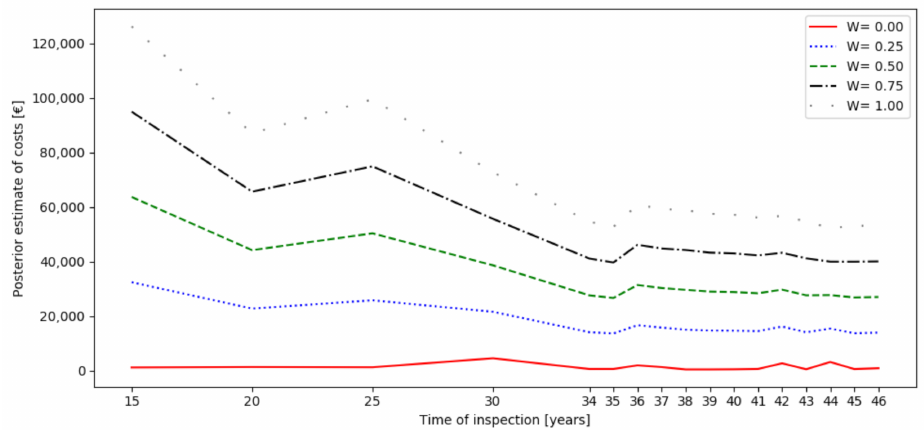
Figure 13. Influence on the uncertainty of the posterior costs when accounting for monitoring data based on the strain mode shapes at different time